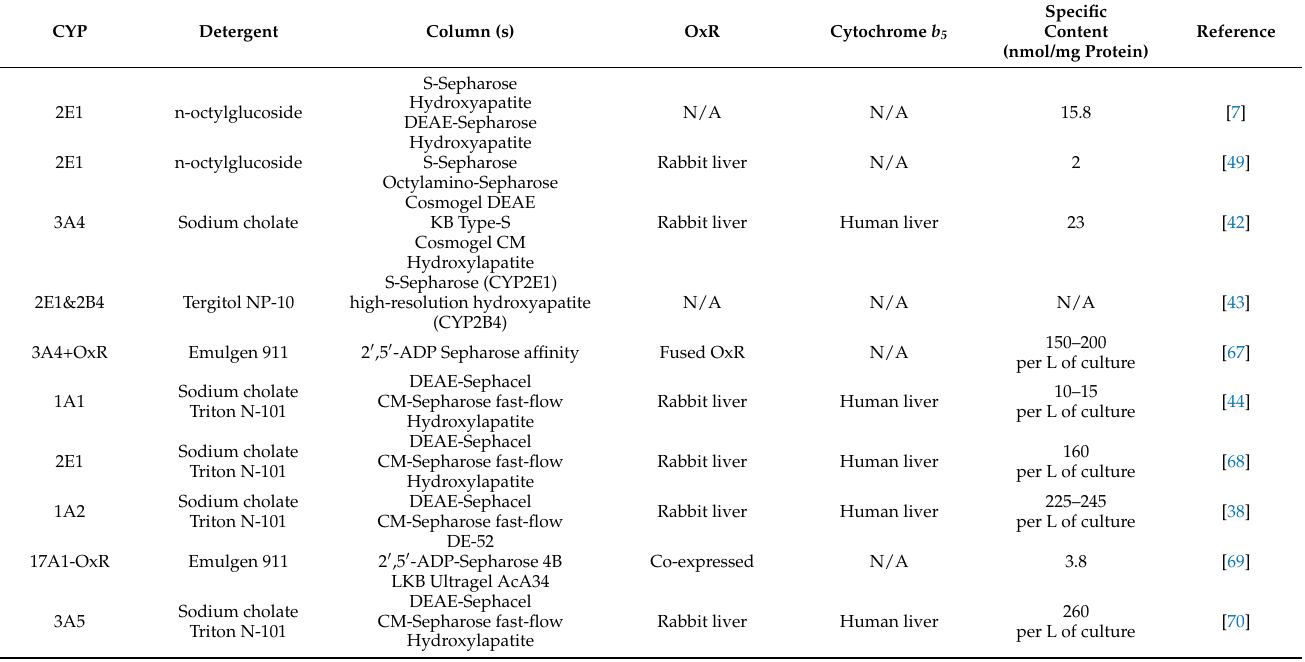
Table 3. Solubilization, purification, and reconstitution of expressed human CYPs from E. coli